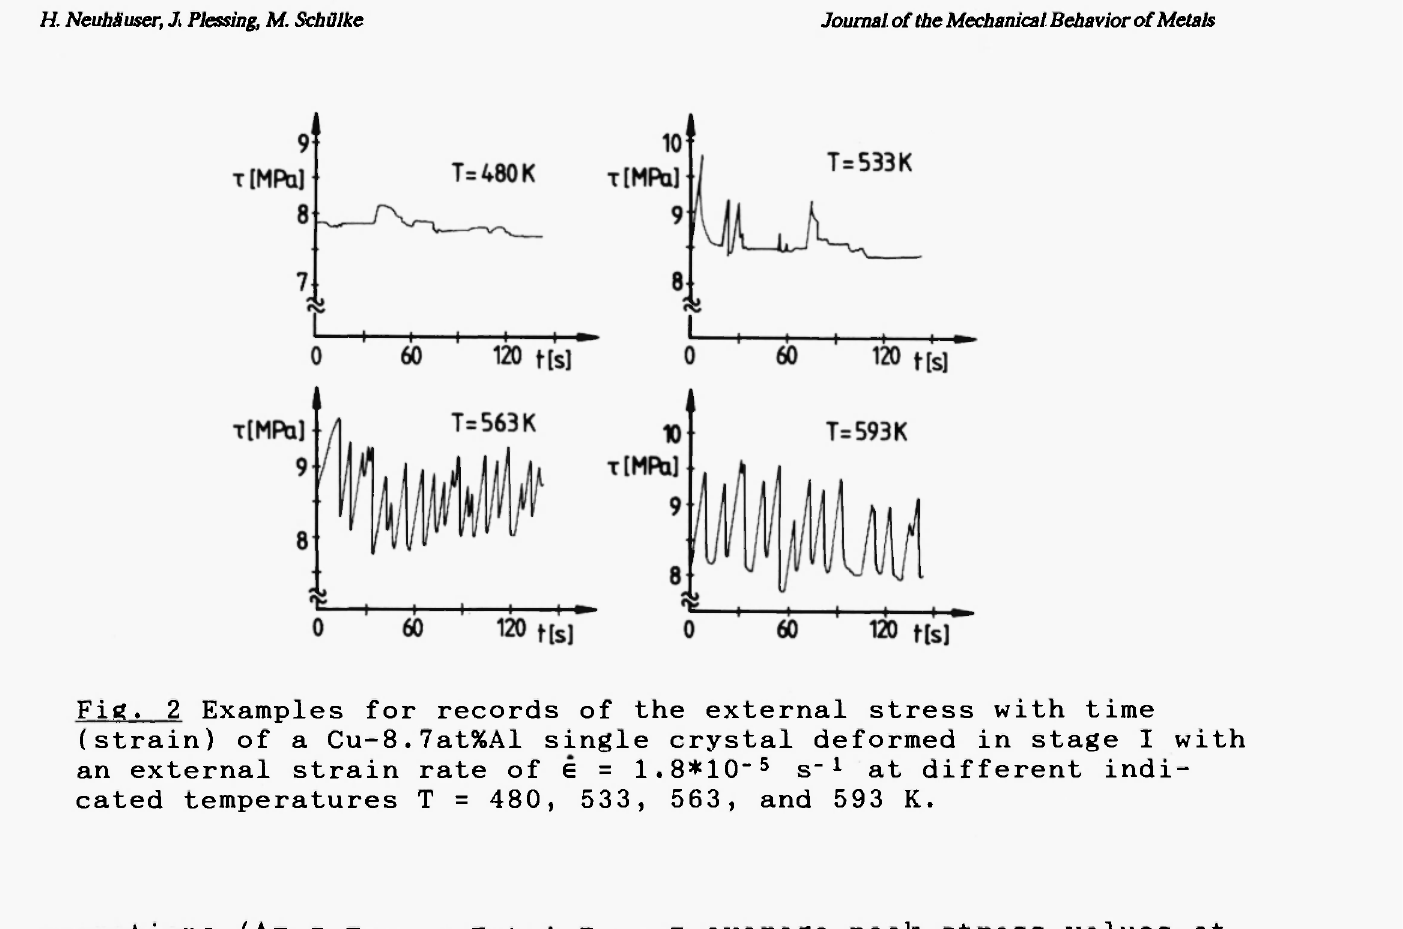
serrations (Δτ = Tmax - xmiη ; Tmax = average peak stress values at the onset of the load drops, τ»ίη = average stresses at their termi- nation) with temperature and solute concentration is shown in Fig. 3, and Fig. 4 gives corresponding histograms to indicate the width of